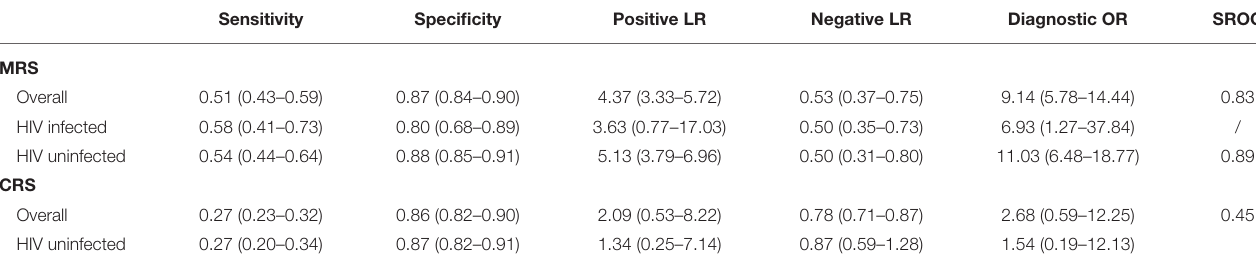
TABLE 2 | Pooled results of FujiLAM in the diagnosis of pediatric patients with tuberculosis.